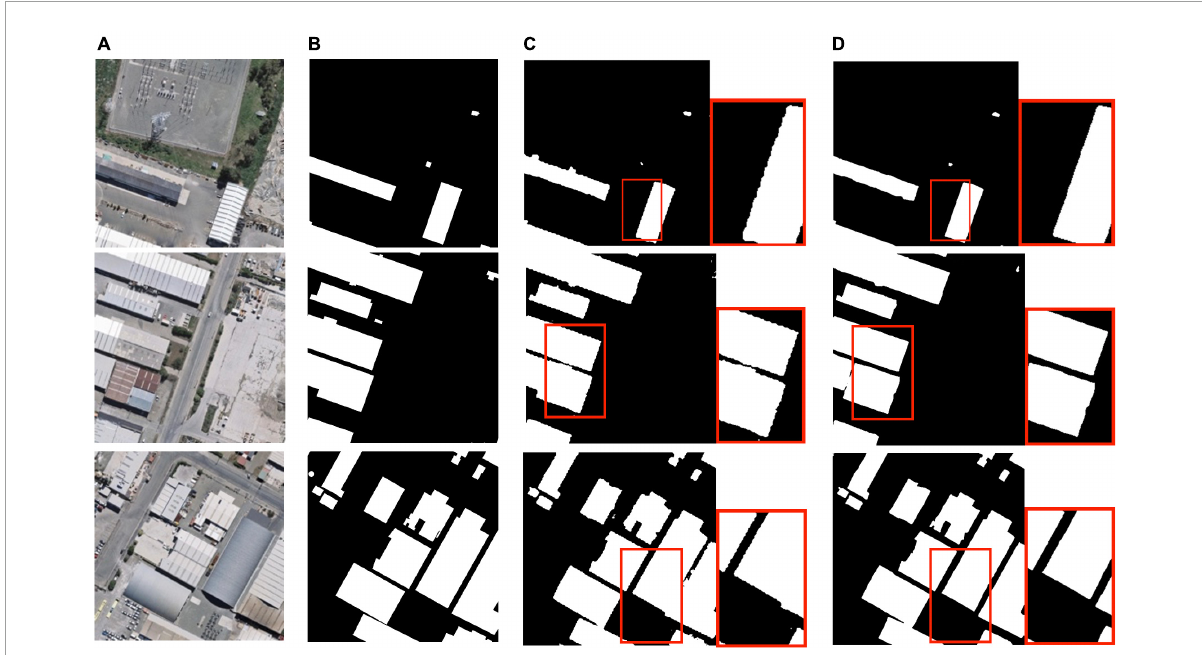
FIGURE7 Building extraction results: (A) original remote sensing image; (B) ground truth; (C) prediction with atrous spatial pyramid pooling; (D) prediction with ASPP and Sobel edge